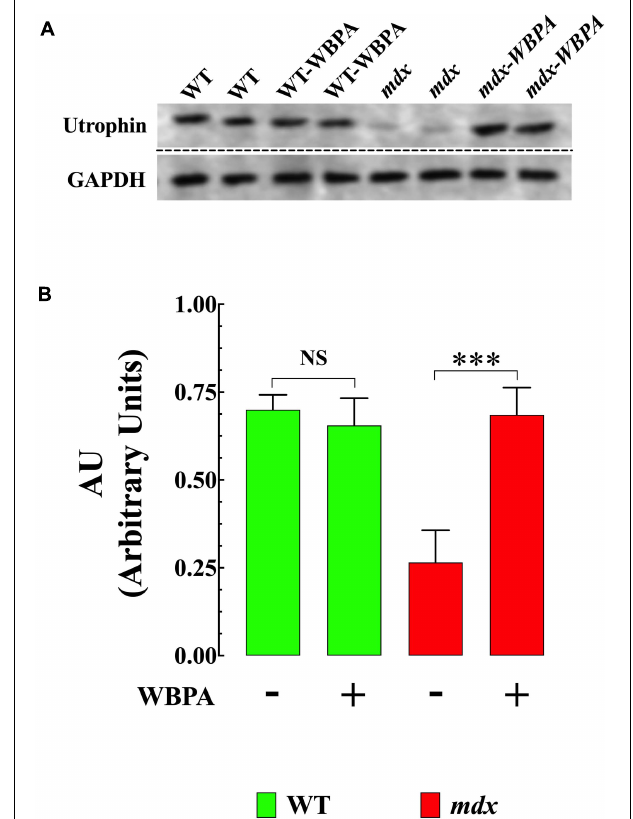
FIGURE 3 | Whole body periodic acceleration enhanced expression of utrophin in mdx heart. (A) Representative Western blot showing the increase in utrophin expression in WBPA-treated mdx dystrophin-deficient heart homogenates compared to heart homogenates from untreated mdx mice. WBPA did not modify utrophin expression in WT. (B) . Illustrated the densitometric analysis of Western blots proteins bands from WBPA-treated and untreated mdx heart. Data were normalized to GAPDH and expressed as mean ± S.D. Untreated mdx N = 3 mice and WBPA-treated mdx N = 3 mice. Paired t -test, *** p ≤